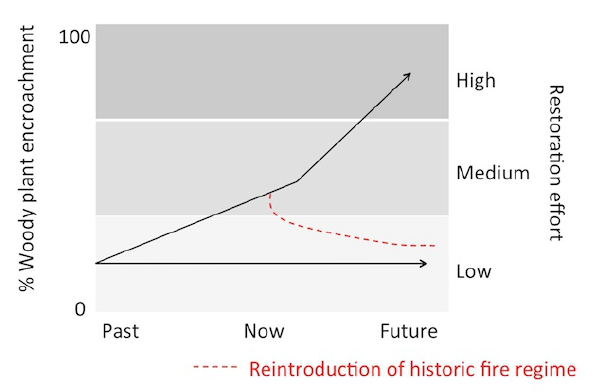
Fig. 1 . Contrasting ecosystem trajectories from historic to present to future configurations, indicating how highly requiring limited or no human intervention. By